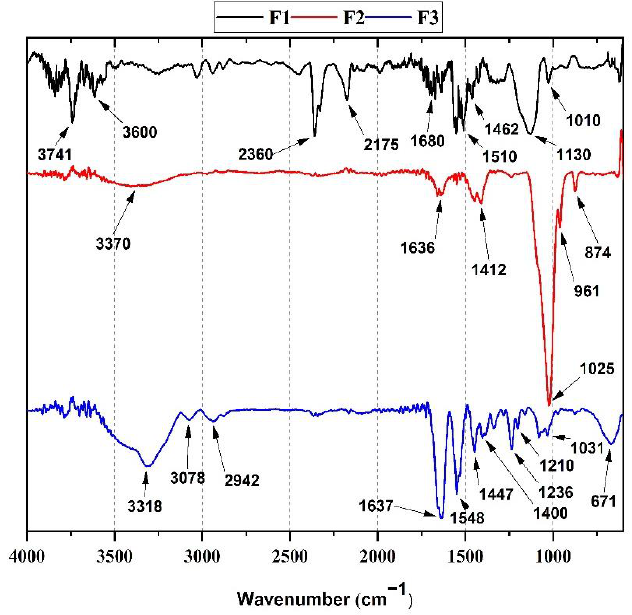
Figure 1. FT-IR spectrum of F1, F2, and F3. According to Table 1, F1: InterOss. F2: InterOss Collagen. F3: InterCollagen Guide.